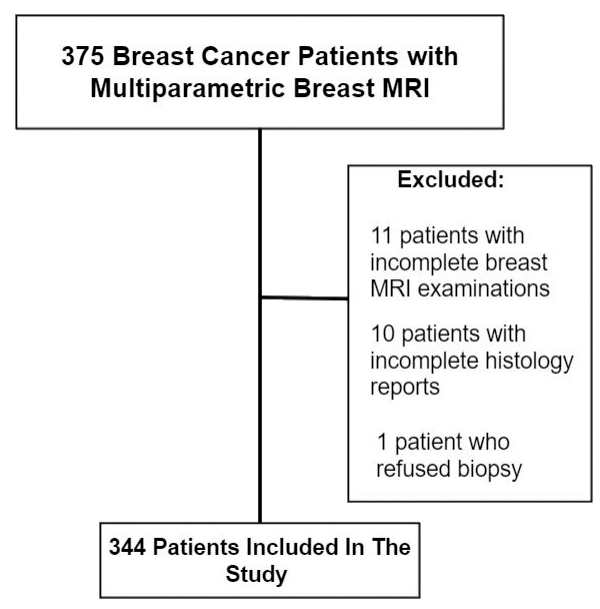
Figure 1. Study population.